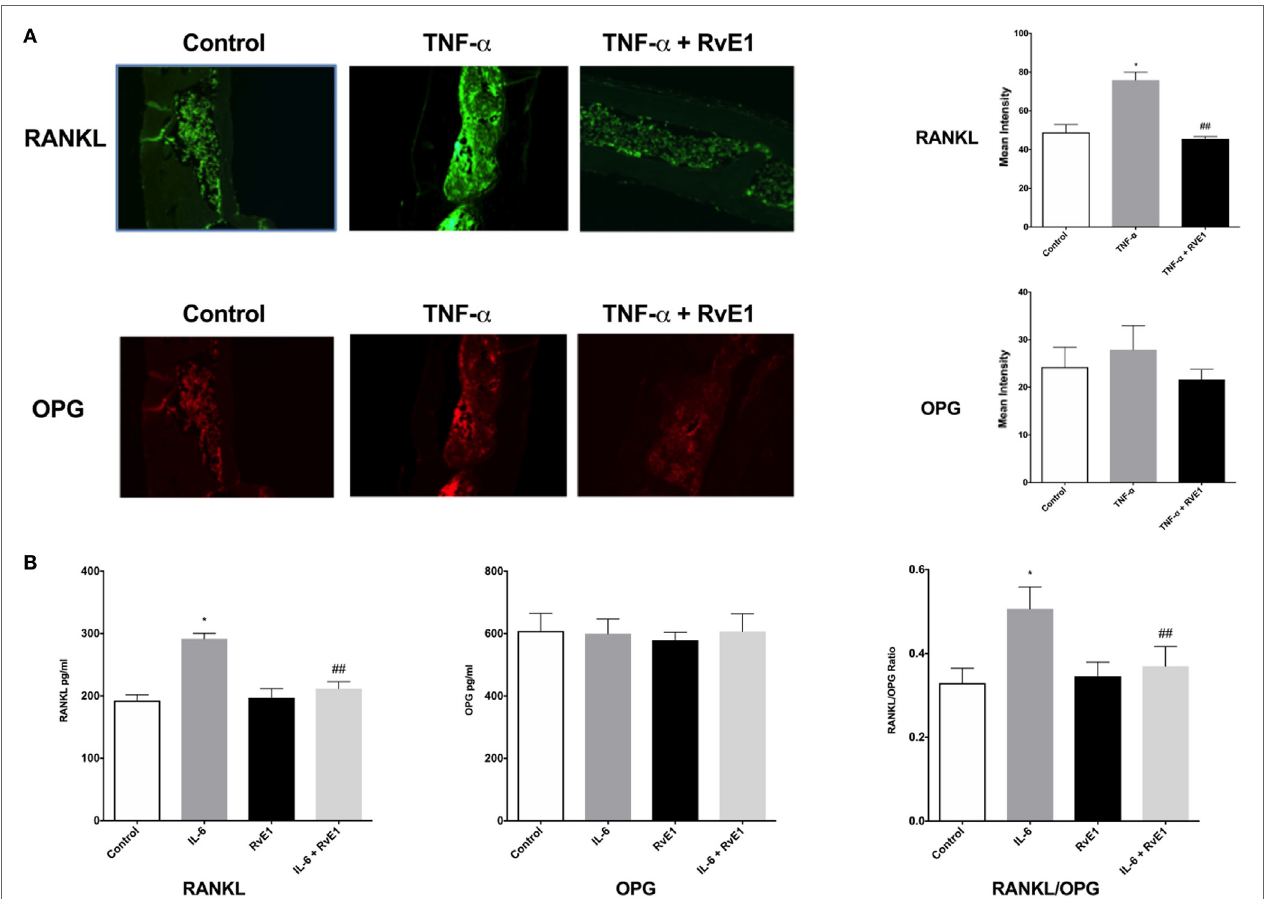
FigUre 2 | (a) Receptor activator of NF κ B ligand (RANKL) and osteoprotegerin (OPG) balance is rescued by resolvin E1 (RvE1). Representative immunofluorescence imaging of primary RANKL monoclonal mouse antibodies conjugated with Alexa Fluor488. Evaluation of Immunofluorescence of histology sections in the different groups was conducted by taking 20 × and 40 × images and using Image J software to compare intensity of fluorescence in medullary areas. The mean immunofluorescence levels were then calculated and compared across groups. In the RvE1 treatment group, mean RANKL immunofluorescence was lower than the tumor necrosis factor- α (TNF- α ) group ( p < 0.05). The same slides stained with Alexa Fluor488 for RANKL immunofluorescence were also double stained with primary OPG monoclonal mouse antibodies conjugated with Dylight550 dye. Evaluation of mean OPG immunofluorescence values revealed no statistically significant differences between all three groups ( p > 0.05). (B) Secreted RANKL and OPG are influenced by RvE1. The results demonstrate that RvE1 suppresses levels of RANKL via direct action on osteoblasts leading to a shift in the RANKL/OPG ratio in favor of bone preservation and formation. RvE1 at 100 nM significantly decreased RANKL production by osteoblasts stimulated by interleukin (IL)-6 ( p < 0.02). Results are expressed as mean of RANKL and OPG levels. * p < 0.05 vs. control. ## p < 0.05 vs. active